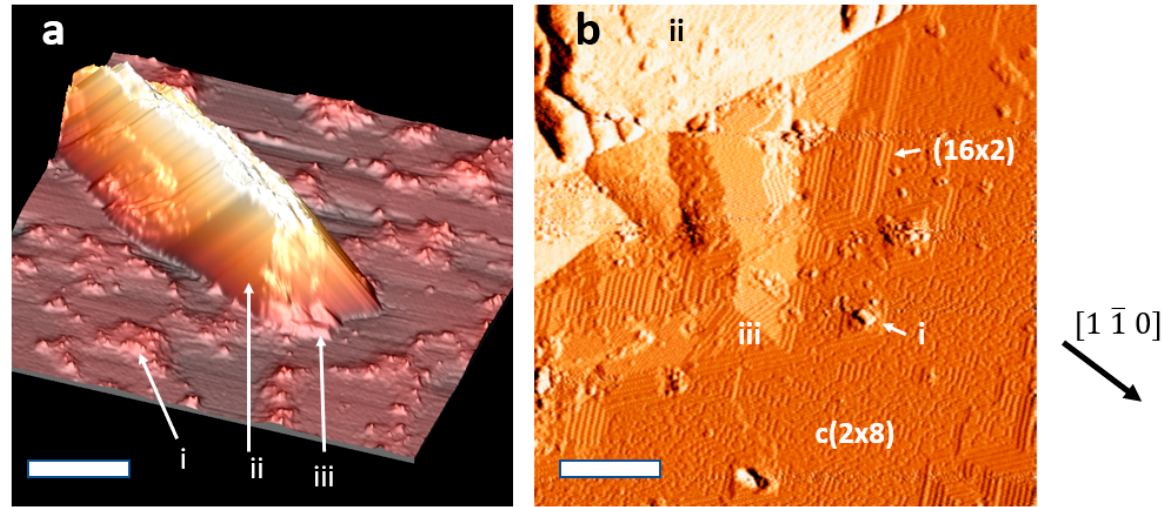
Figure A2. Deposition of ~10 MLs of Ag on Ge (110), annealed to 177 °C, and cooled to RT for imaging. ( a ) A 3D STM topographical image of a 1D Ag island on a Ge (110) substrate. ( b ) Topographical STM image of the boundary of a pyramid showing magnified region “iii” from ( a ). Scale bars: ( a ) 200 nm, ( b ) 40 nm.